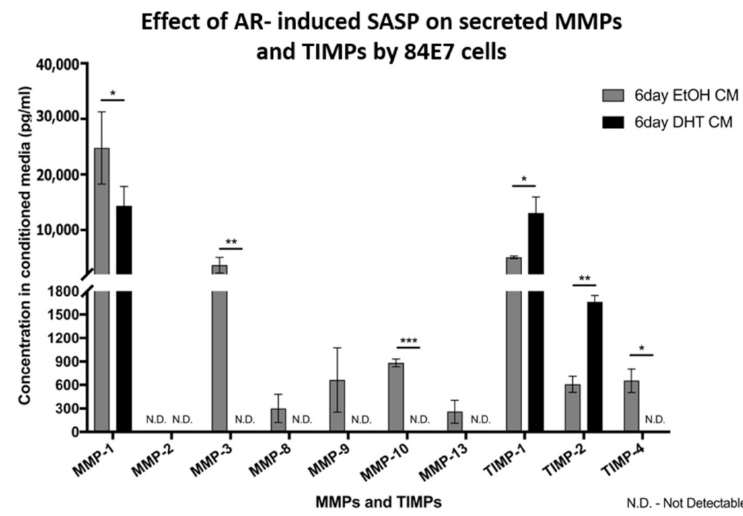
Figure 12. Effect of AR-activation on MMP and TIMP levels in the SASP. Continuous activation of ARs in androgen-responsive 84E7 cells shows a significant decrease in MMP-1, -3, and -10 and a moderate increase in inhibitors TIMP-1 and TIMP-2 (* p -value < 0.05, ** p -value < 0.005, *** p -value <